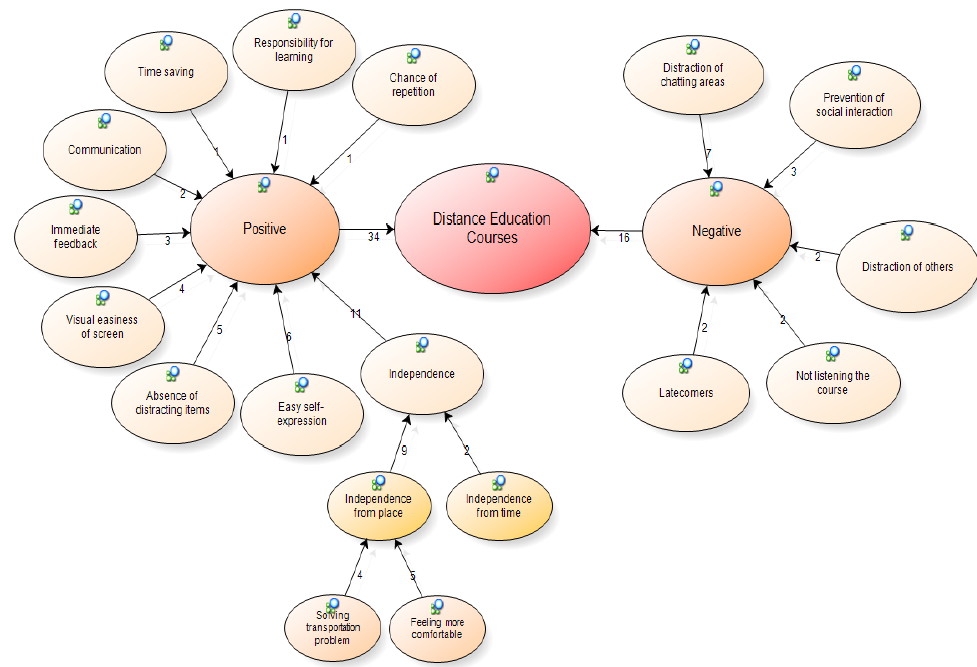
Figure 3. The model related to the positive and negative aspects of lecturing in the distance education